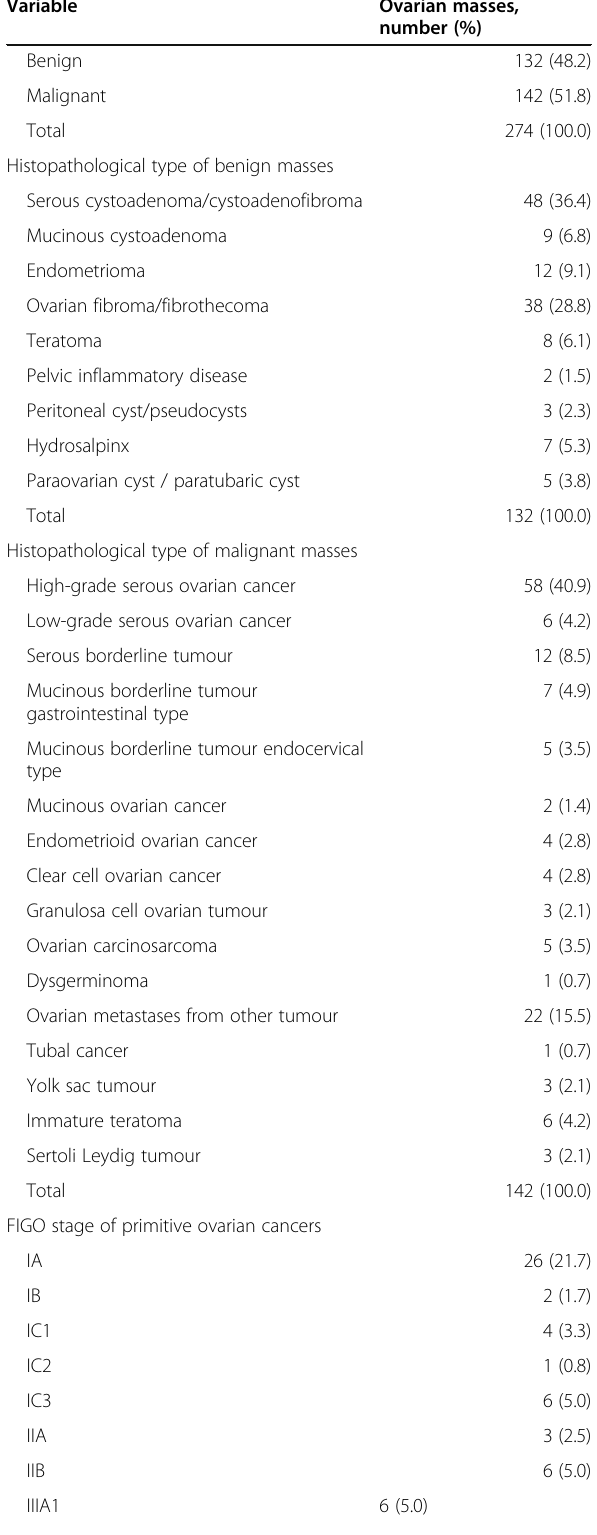
Table 3 Histopathological characteristics of ovarian masses